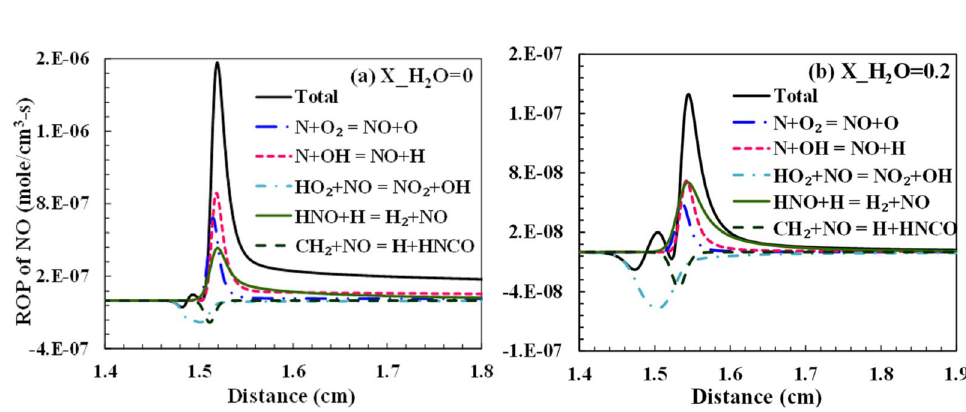
Figure 15. The net rate of NO production with ( a ) 0% and ( b ) 20% steam dilution using the GRI-3.0